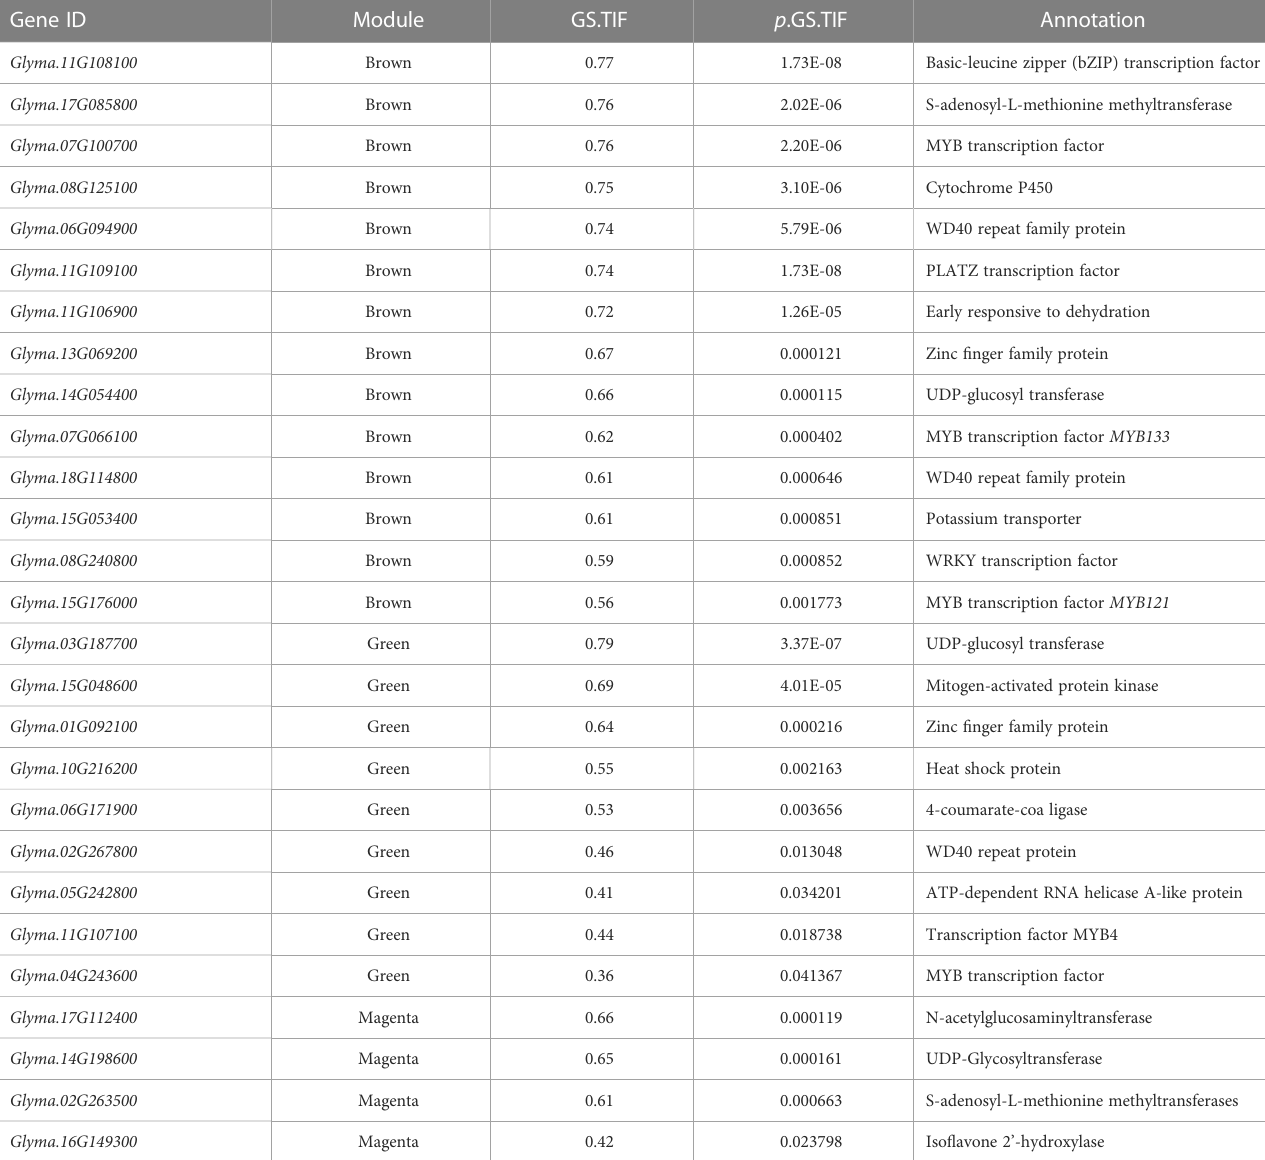
TABLE 1 List of candidate genes for individual and TIF content in brown, magenta, and green modules. Gene ID